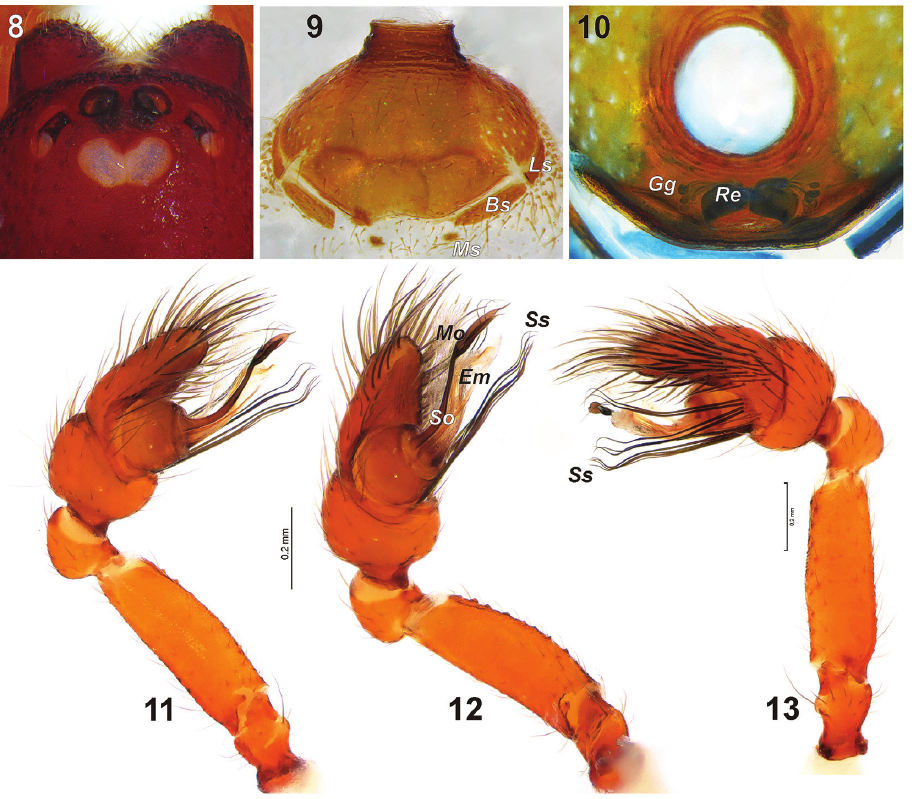
Figures 8–13. Diaphorocellus biplagiatus. 8 eye pattern in female, dorsal 9 epigastric scutum, female, ventral 10 epigastric scutum after maceration, caudal view 11–13 male palp, prolateral, ventro-prolateral and retrolateral. Abbreviations: Bs sclerite opposite to book lungs; Cs strong cymbial setae; Em “embolus”; Gg grape-shaped gland; Ls lateral sclerite; Mo membranous outgrowth; Ms median sclerite; Re receptacle; So sclerotised